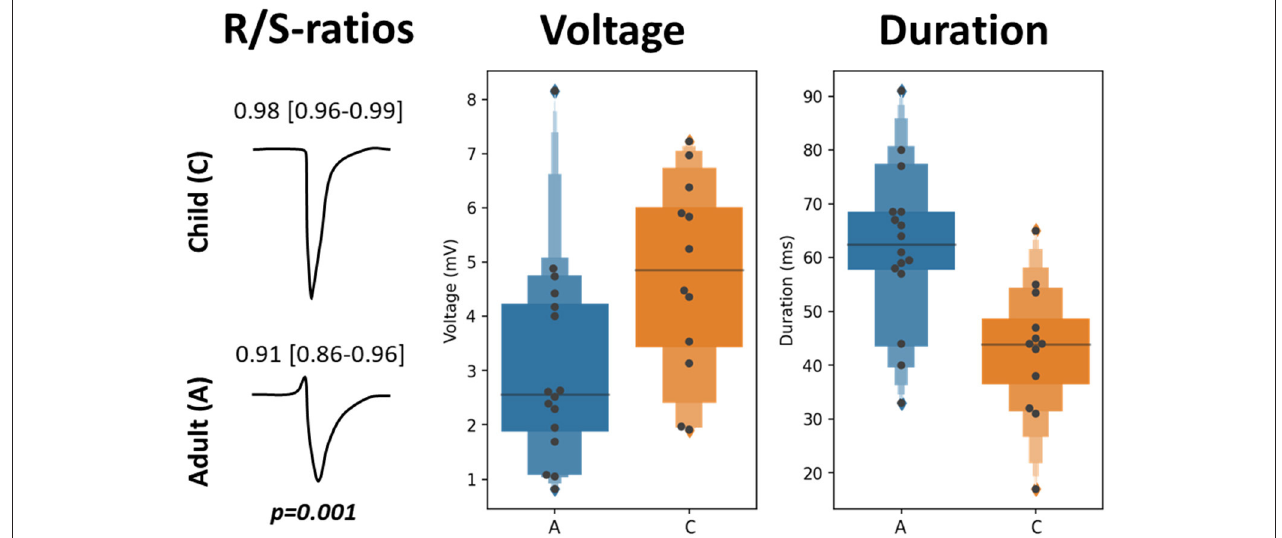
FIGURE 3 | EGM morphology characteristics at the SAN-FAP origin. Two typical examples of EGM morphologies at the SAN-FAP origin obtained from a pediatric (top) and adult patient (bottom), and the corresponding R/S ratios (left panel). The SP voltage (center) and duration (right) distributions obtained from the adult (blue) and pediatric (orange) population are shown in the